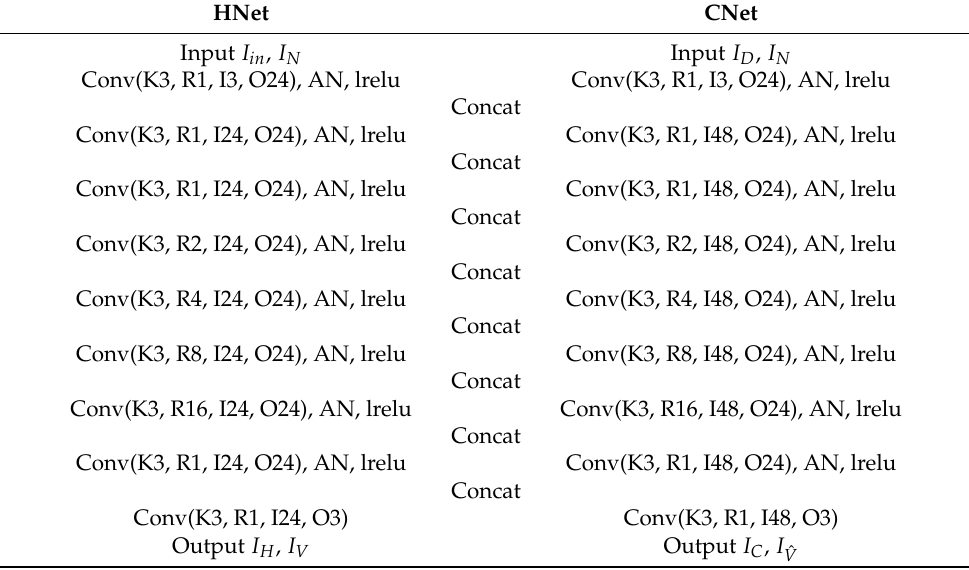
Table 2. Details of the proposed DVNet, where Conv denotes a convolution operator, K3 is kernel size of 3 × 3, R is dilation rate, I input channel, O output channel, AN Adaptive normalization, and lrelu is leaky relu.